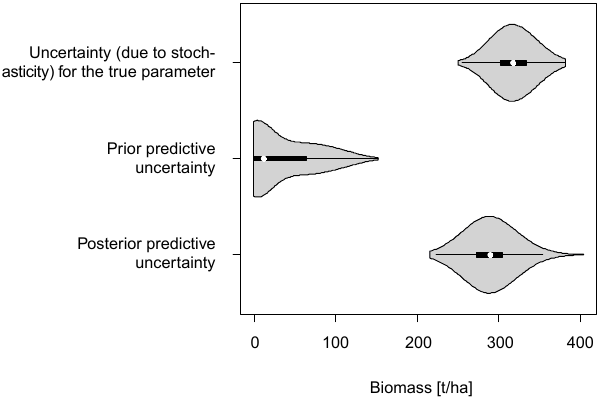
Fig. 4. True, prior and posterior predictive uncertainty. Each dis- tribution is created from 1000 model runs, observing the biomass on a 1ha forest plot after 2000 years. The upper distribution shows biomass values from model runs with the same, “true” parameters (Table 2, Supplement), and thereby gives an estimate of the stochas- tic uncertainty of the model. For the middle distribution, model pa- rameters were drawn from the prior distribution (resulting in what is called the prior predictive distribution). For the lower distribution, model parameters were drawn from the posterior (posterior predic- tive